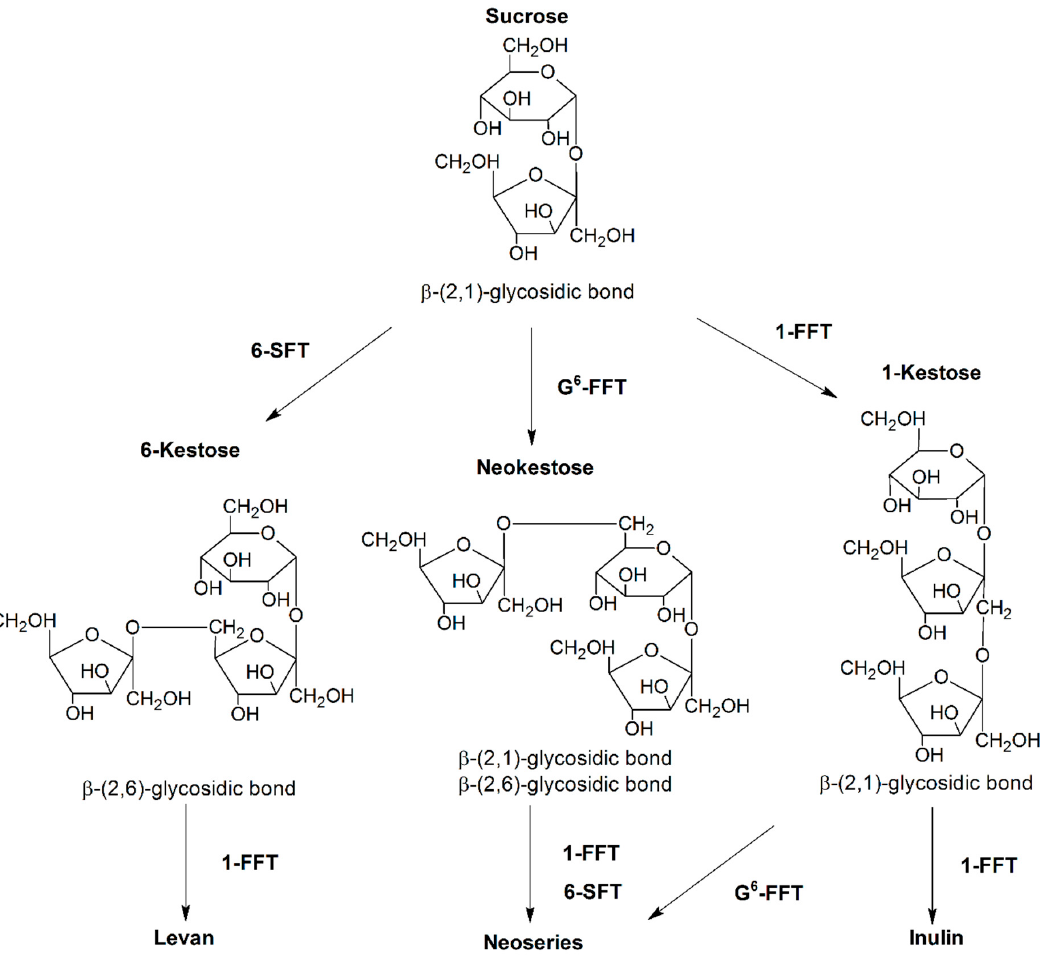
Figure 1. The Fructo-oligosaccharides (FOS) synthesis pathways starting from sucrose. G 6 -FFT = G 6 -fructosyltransferase; 1-FFT = 1-fructosyltransferase; 6-SFT = sucrose:fructan-6-fructosyltransferase.